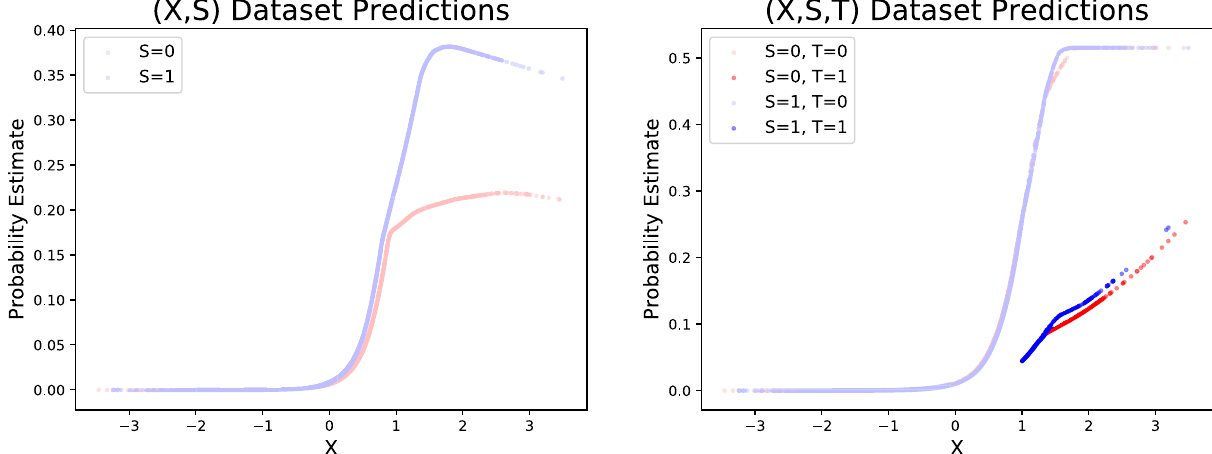
Figure 17. Model predictions for all patients (dots) in the synthetic medical dataset. S represents a sensitive attribute like Skin color. When the treatment T is biased on S, we observe how much the model relies on S for prediction (left). When source of bias is appropriately included in the model, we can both confirm the source of bias and remove the dependency on sensitive attributes from the predictive models